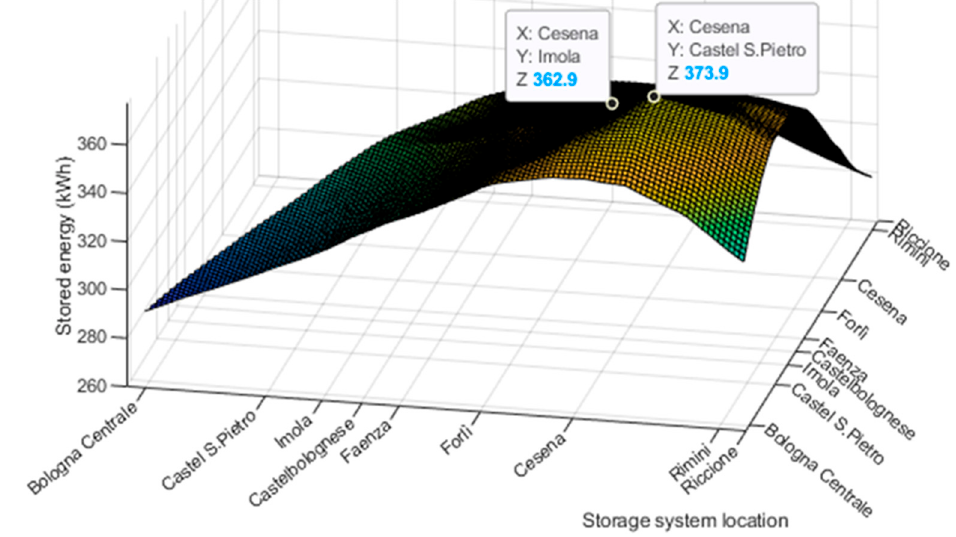
Figure 8. Recovered energy on varying the location of the two ESSs with 3300 V as supply voltage level.